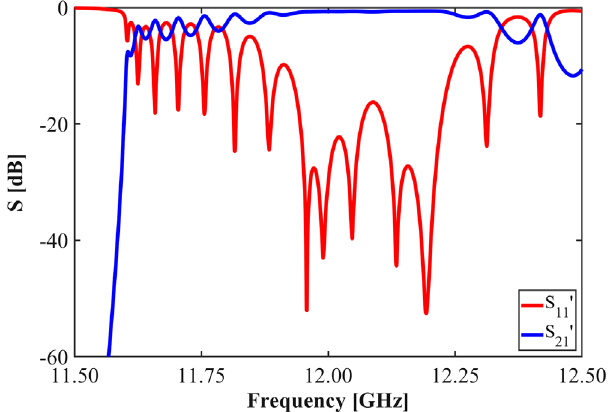
parts.FIG. 11. Simulated S 0 11 and S 0 21 as a function of frequency for the full-assembly structure shown in Fig. 10.